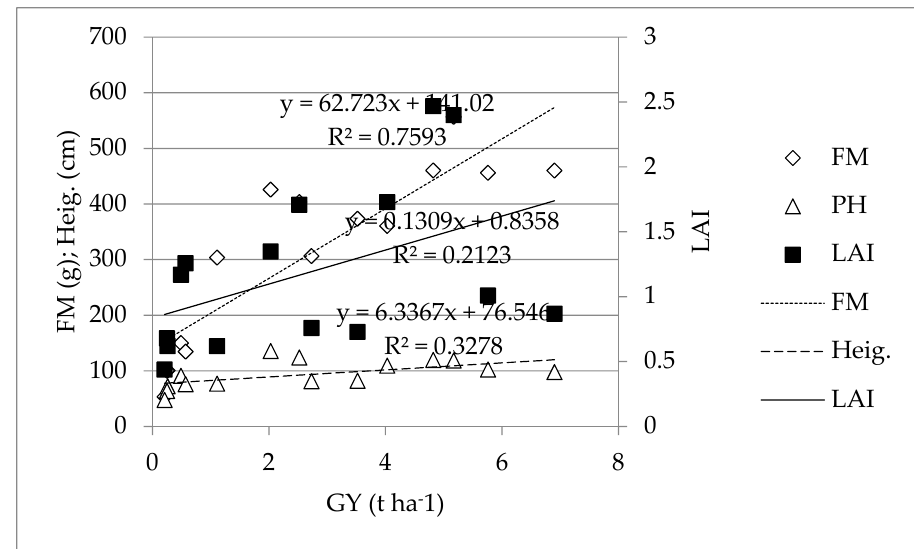
area index (LAI) 21 DAT when FP fertilizer was applied.